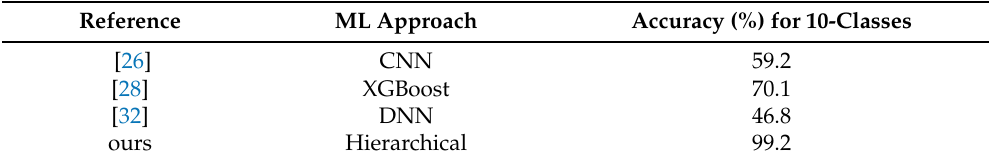
Table 5. Comparison between our approach and other related approaches using same